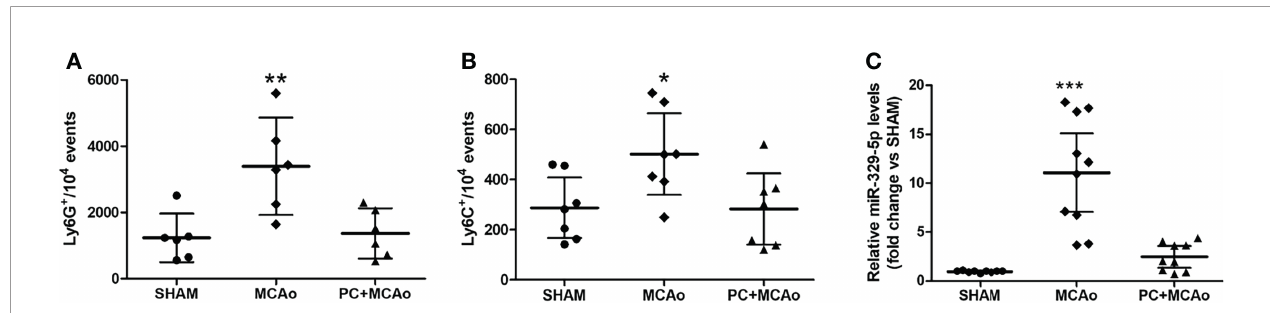
FIGURE 1 | Ischemic PC attenuates the systemic in fl ammatory status caused by severe ischemia. (A) Circulating Ly-6G+ neutrophils, (B) Ly-6C+ monocytes and (C) plasma miR-329-5p levels in mice subjected to SHAM surgery, 1h MCAo preceded by sham surgery (MCAo) or by ischemic PC (15min MCAo) 72h before (PC+MCAo). *P = 0.0463 vs SHAM and P = 0.0412 vs PC+MCAo, **P = 0.0049 vs sham and P = 0.0080 vs PC+MCAo, ***P = 0.000003 vs SHAM and P = 0.00004 vs PC+MCAo (one-way ANOVA followed by Tukey ’ s post-hoc test, n=6-10 mice per experimental